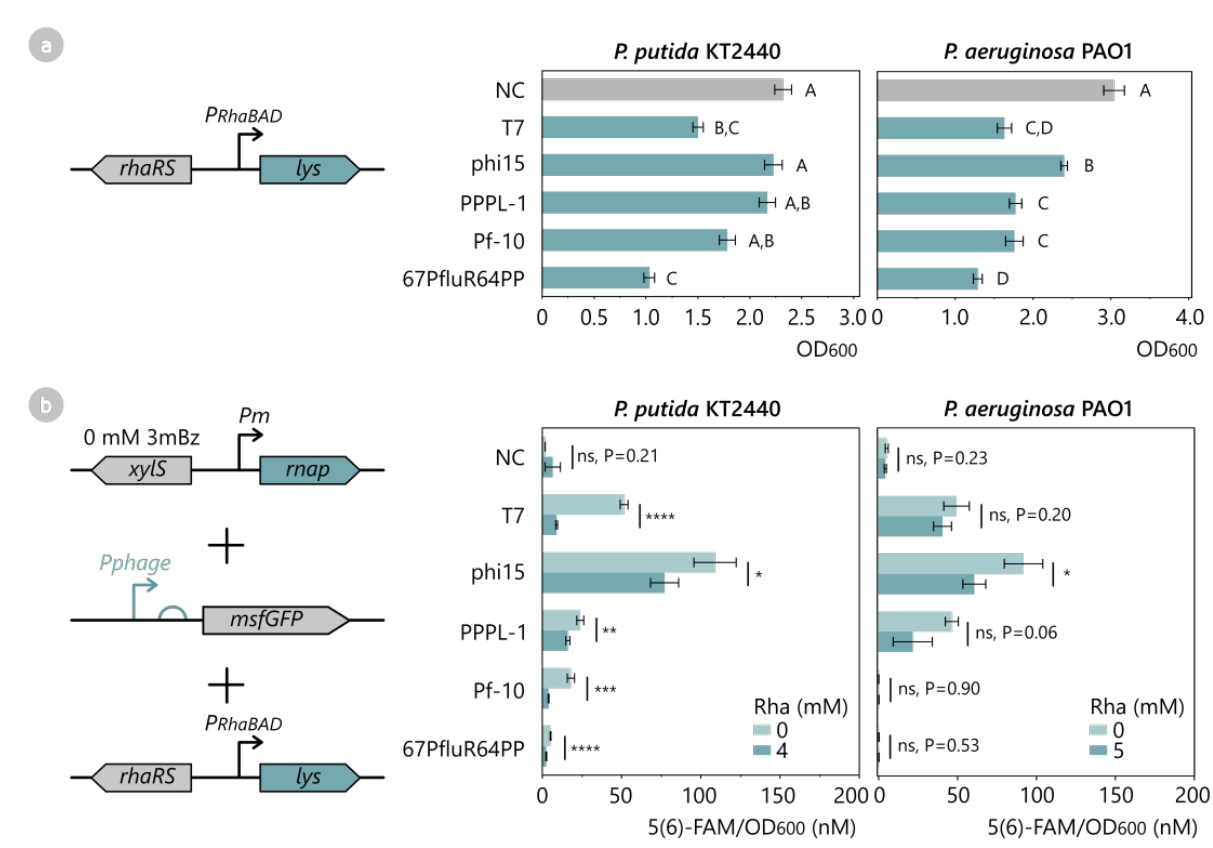
Figure 6. ( a ) Toxicity assay of phage lysozymes in P. putida KT2440 and P. aeruginosa PAO1. All phage lysozymes of T7, phi15, PPPL-1, Pf-10, and 67PfluR64PP, as well as an empty pSTDesR control vector (NC), were introduced in P. putida and P. aeruginosa and were induced with 10 mM Rha at OD 600 0.3, after which cell growth was monitored for 12 h. Bars and error bars represent the mean and standard error of four biological replicates. Samples not connected by the same letters are significantly different (Tukey HSD, α = 0.05). ( b ) Fluorescence assay to analyze the inhibitory effect of the phage lysozyme on its corresponding phage RNAP. All phage RNAPs, lysozymes, and phage promoter-msfGFP reporter constructs of T7, phi15, PPPL-1, Pf-10, and 67PfluR64PP and empty control vectors (NC) were introduced in P. putida and induced with 4–5 mM Rha for 12 h. Data points represent the mean 5(6)-FAM/OD 600 value of four biological replicates, while error bars represent the standard error. Significance levels are indicated for one-sided Student’s t -tests, with *: p < 0.05, **: p < 0.01, ***: p < 0.001 and ****: p < 0.0001. Full growth curves and fluorescence expression levels over time of ( a , b ) are available in Figure S5.